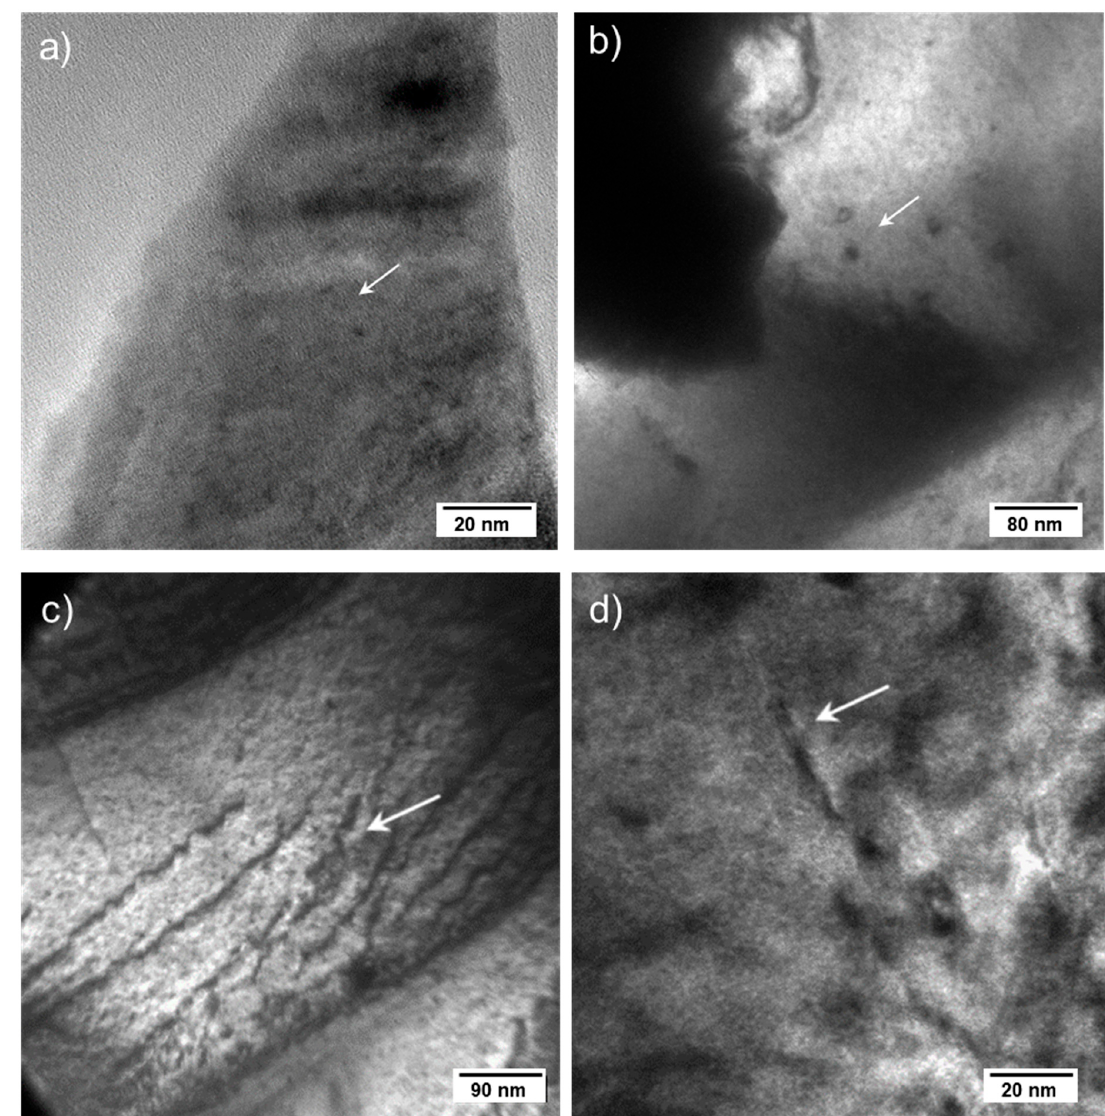
Figure 7. TEM bright field micrographs of sample SF14 (15.9 dpa) showing ( a , b ) dislocation loops, ( c ) dislocation lines, ( d ) dislocations and helium nanometric bubbles (bright spots). All mentioned features are indicated by arrows in the corresponding images.